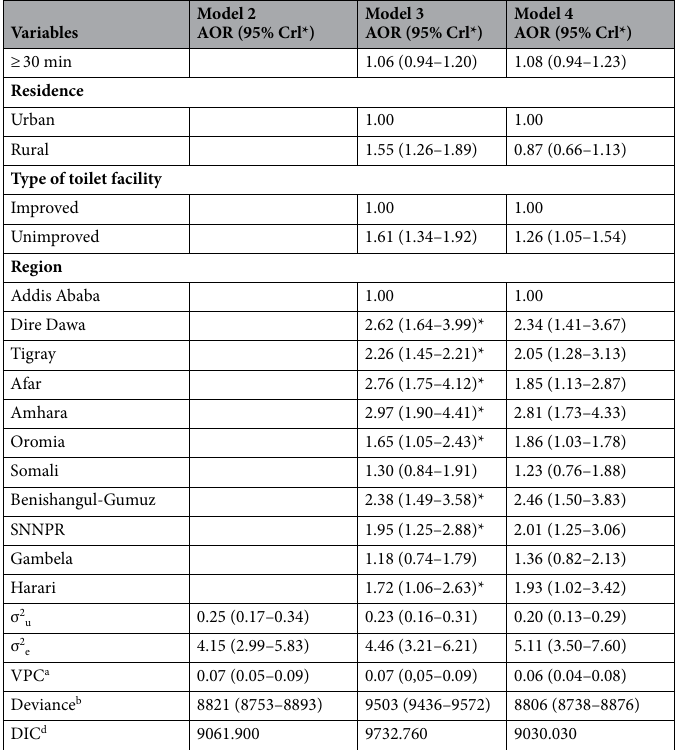
Table 3. Multi-level logistic regression analysis of factors associated with childhood stunting in Ethiopia by using Bayesian statistical inference from January 18, 2016 to June 27, 2016 (n = 8117). Crl*: is Bayesian Credible Interval, σ 2 u : is residual variance between clusters , σ 2 e : residual variance between individuals in the same cluster , VPC a : is variance partition coefficient, Deviance b : is − 2log (L), DIC d : is deviance information criterion (model fit